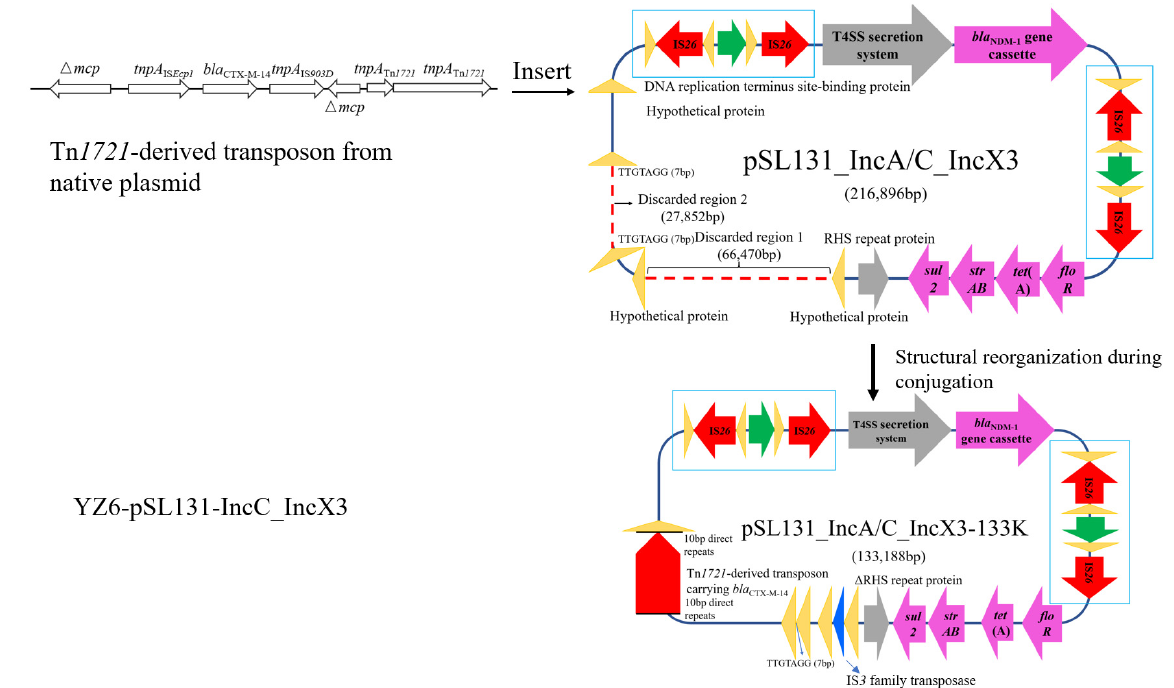
Figure 3. Schematic diagram of structural reorganization of pSL131_IncA/C_IncX3 after being conjugated into YZ6. Regions marked with dashed lines indicated discarded sequences; 66 kb was replaced by gene encoding IS 3 family transposase. Deletion of the 27 kb region was mediated by short sequence homologies. The bla CTX-M-14 gene from native plasmid was inserted into a gene-encoding DNA replication terminus site-binding protein mediated by Tn 1721 -derived transposon and left two 10 bp direct repeats.